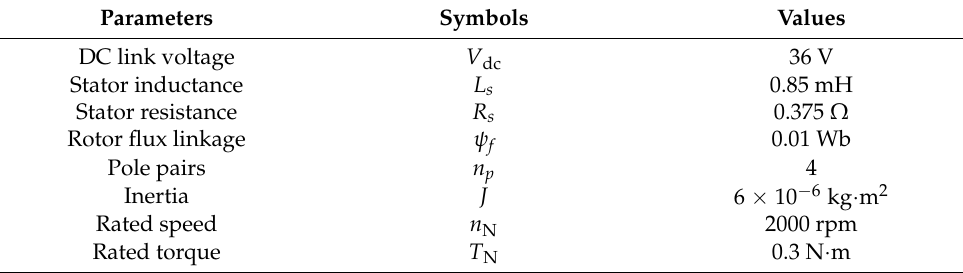
Figure 4. Experimental platform for verifying the proposed MPDSC. Table 1. Parameters of the PMSM drive system.